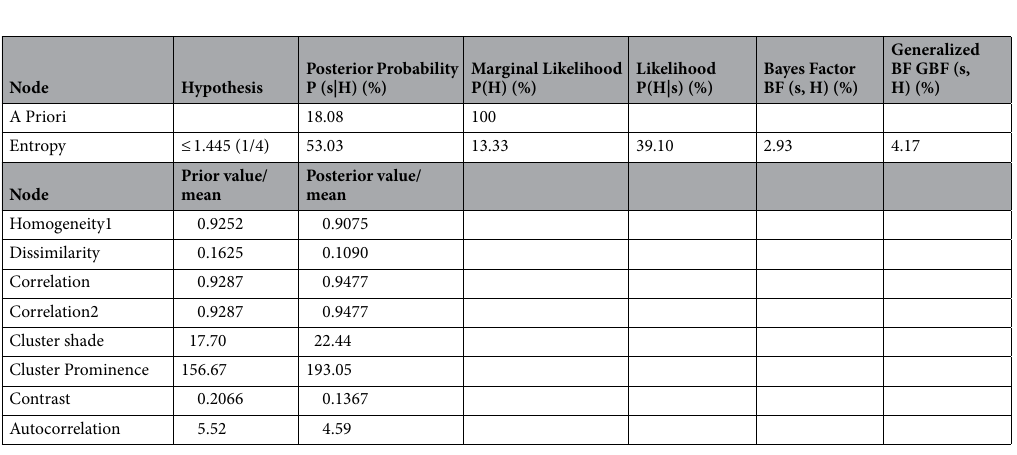
Table 7. Search method: hard evidence dynamic profile energy: probability maximization (likelihood) Energy ≤ 0.471